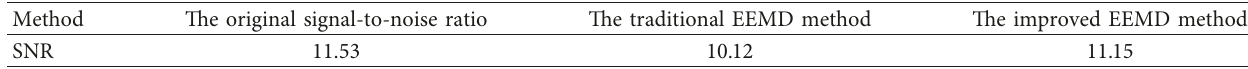
Figure 6: Denoising effect comparison chart. Table1: Denoising effect comparison.